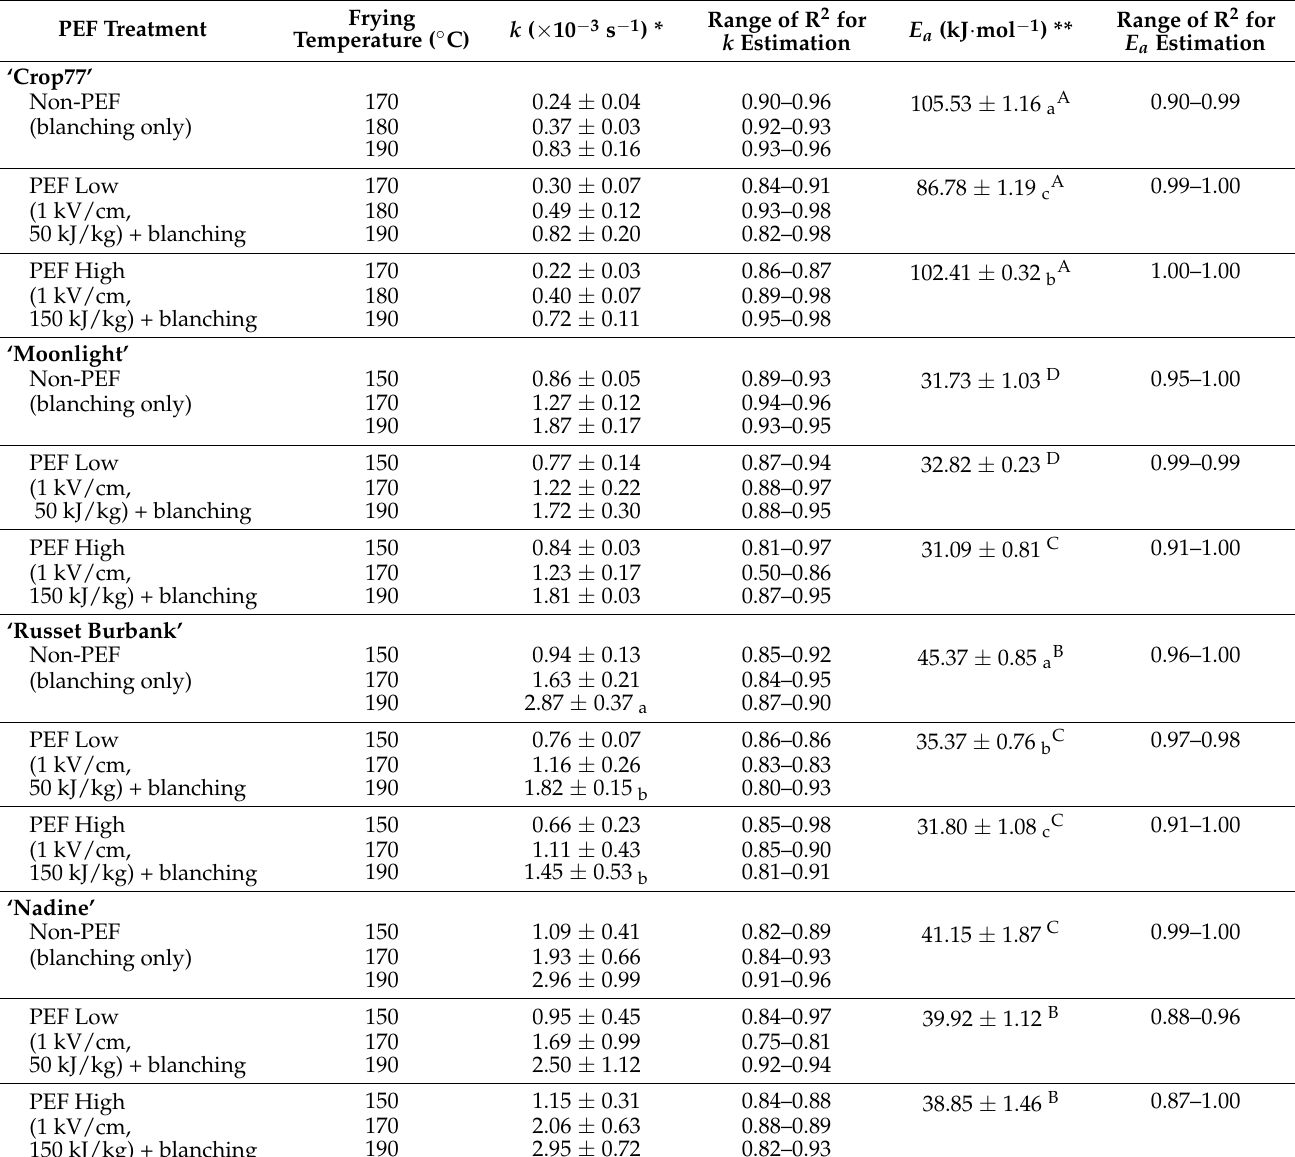
Table 4. Estimated kinetic parameters of time dependence k and temperature dependence E a of changes in lightness ( L *) of fried potato slices produced from cultivars ‘Crop77’, ‘Moonlight’, ‘Nadine’ and ‘Russet Burbank’ without and with PEF pre-treatment followed by